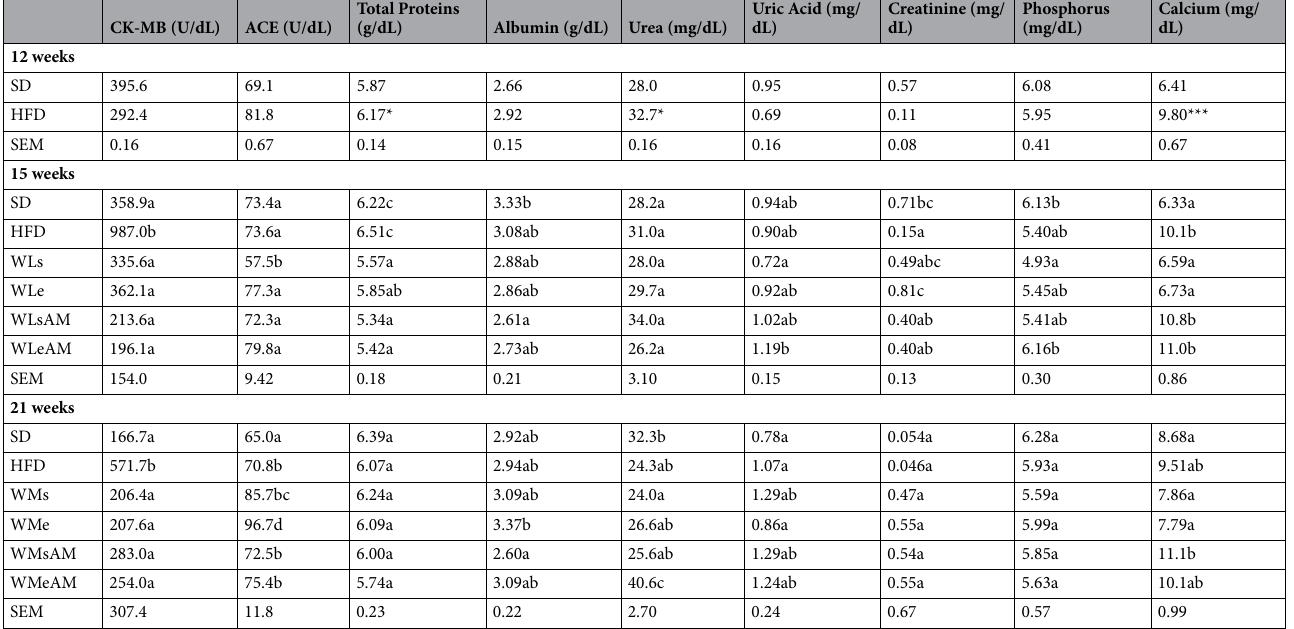
Table 2. Effects of DIO and weight control interventions on plasma parameters of heart and kidney functionality. SD standard rat chow diet, HFD hypercaloric diet for dietary induction of obesity, WLs